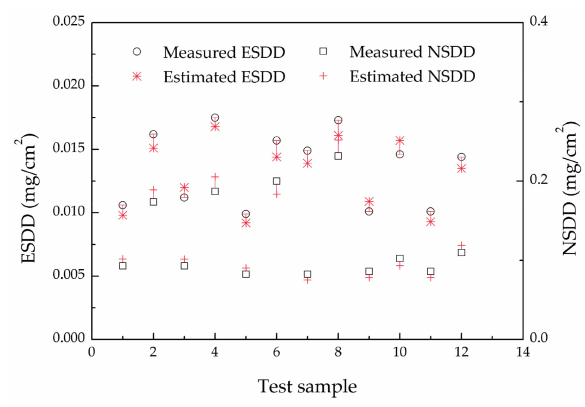
Figure 18. The results of the artificial natural pollution